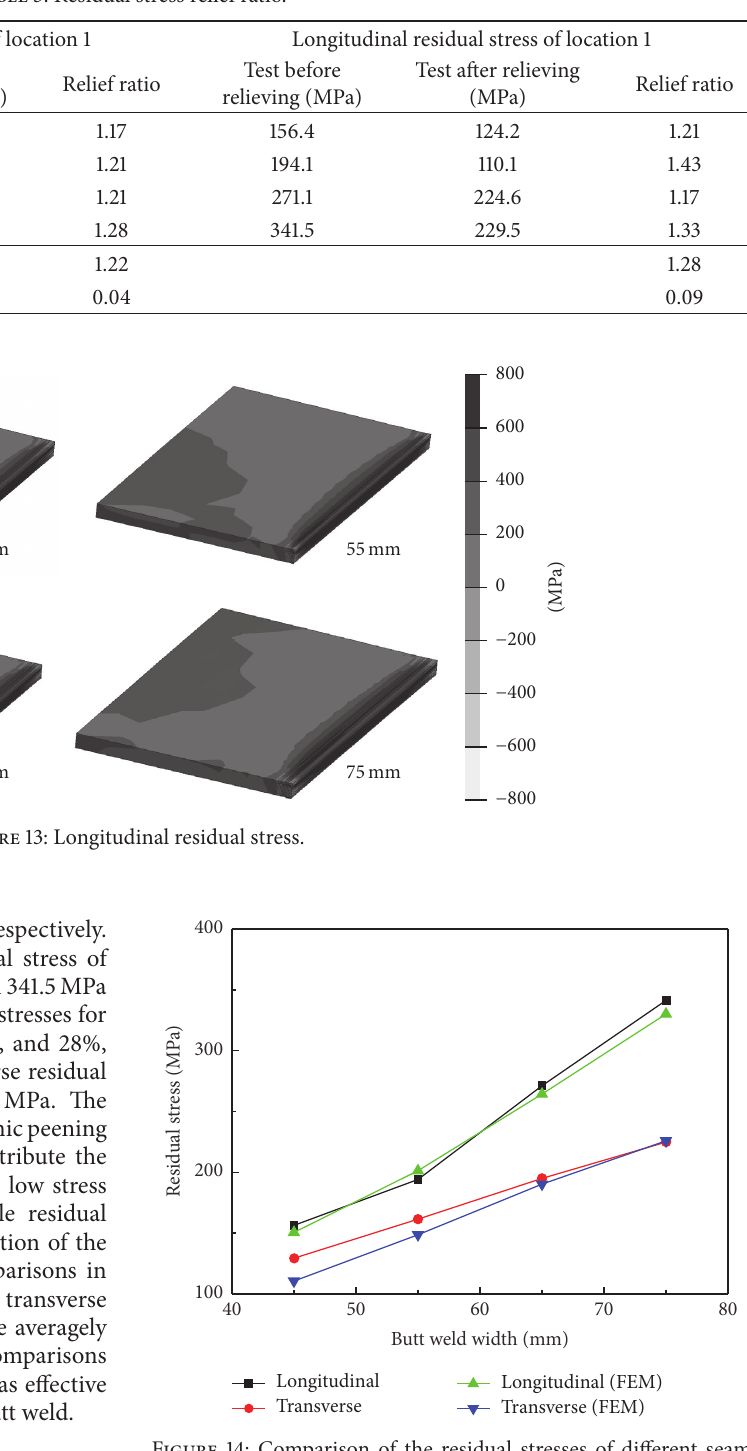
Figure 14: Comparison of the residual stresses of different seam